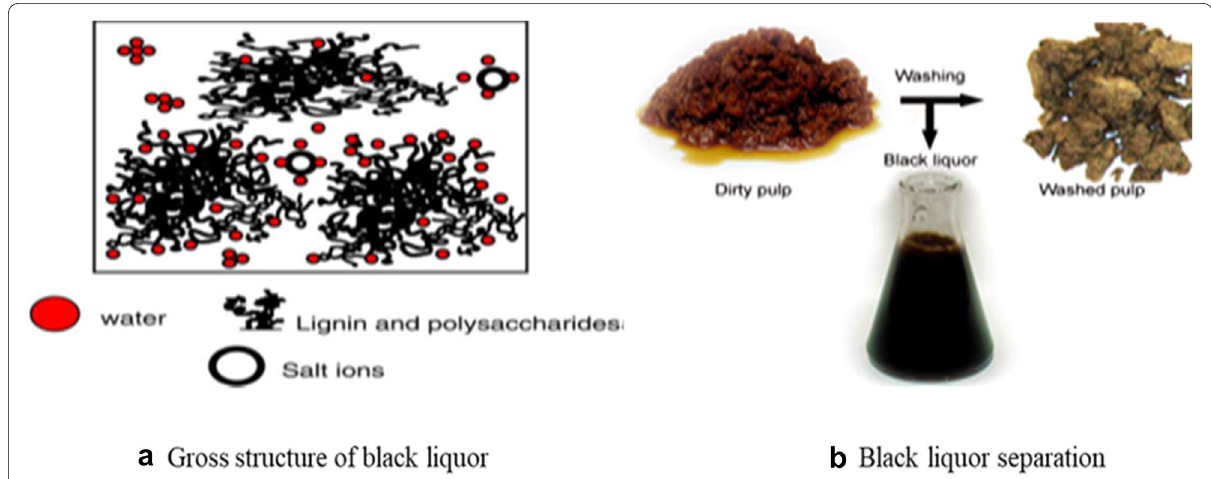
Fig. 5 Black liquor: a Gross structure of black liquor; b Black liquor